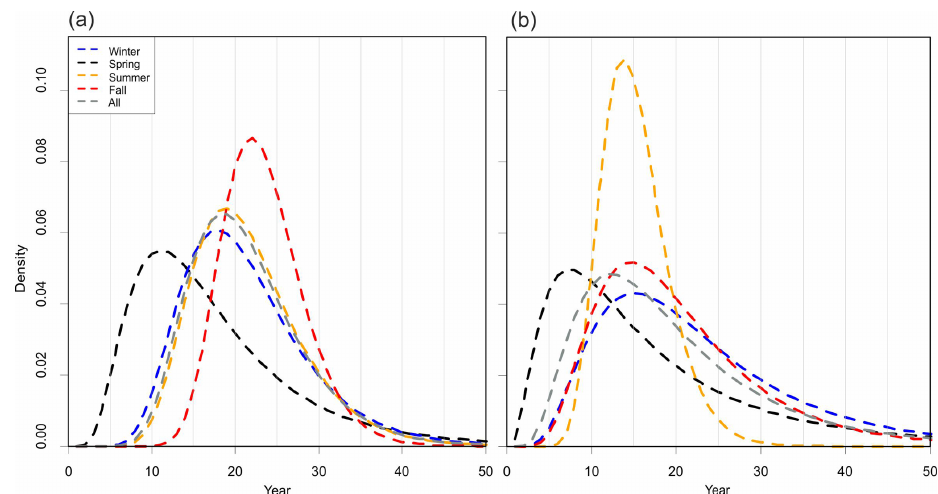
Figure 5. Seasonal variations in the fitted log-normal distributions of effective travel times between nitrogen input and output responses for midstream (a) and downstream (b)